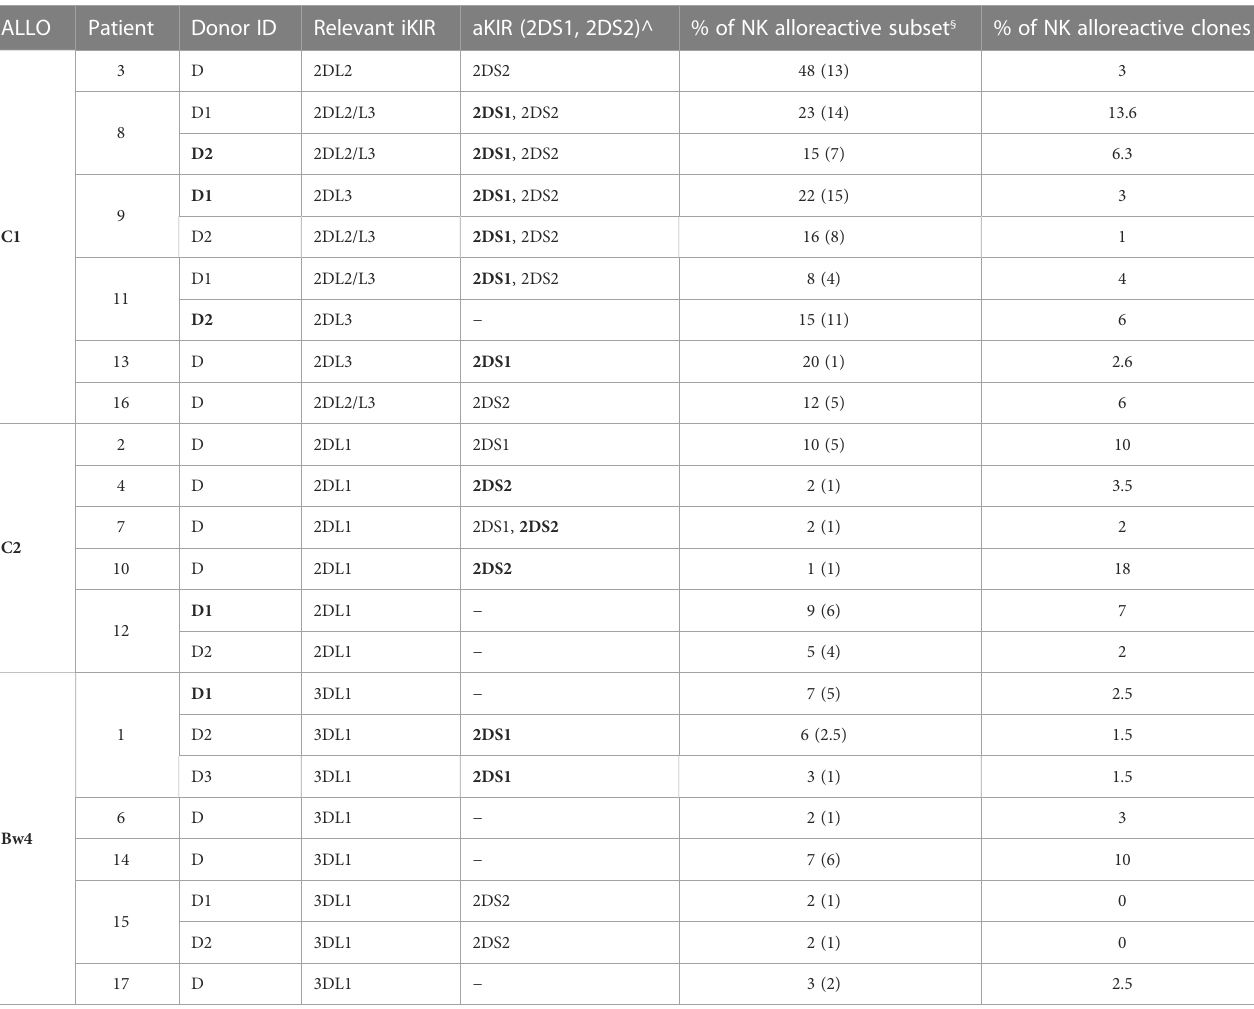
TABLE 2 NK alloreactive subsets and relevant KIRs in the various donor/patient pairs. ALLO